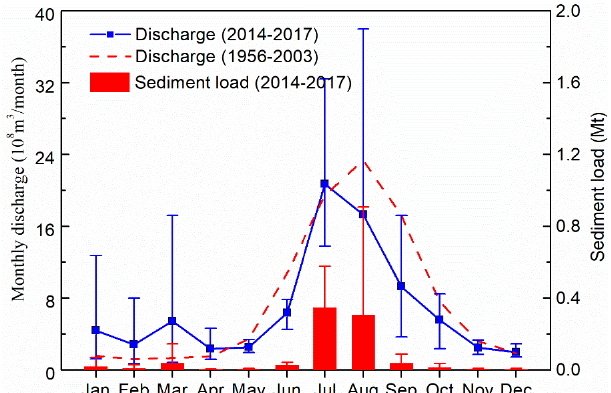
Figure 6. Average monthly discharge and sediment loads of the Lhasa Station.